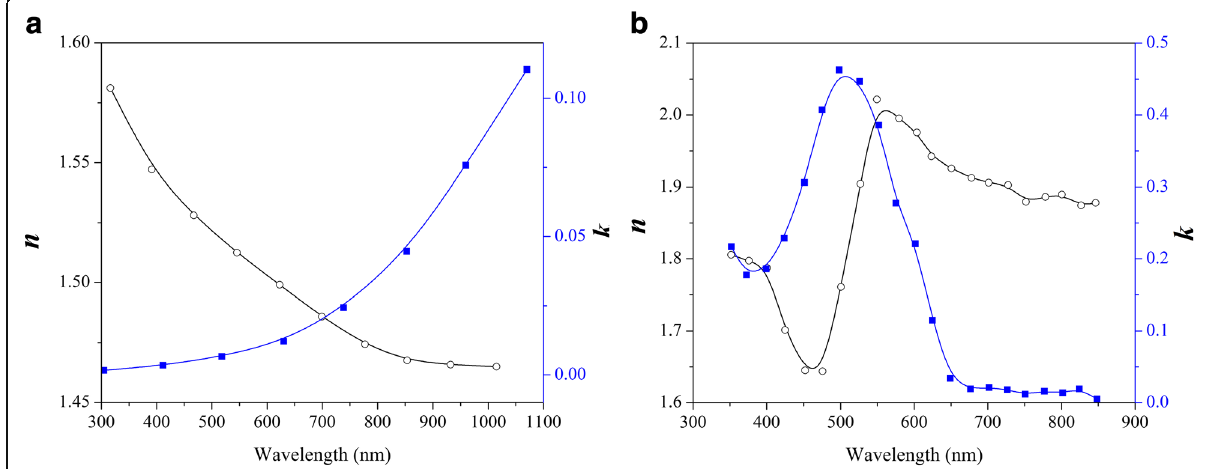
Fig. 1 The complex refractive index n and extinction coefficient k of PEDOT: PSS a and P3HT: PCBM b in the FDTD